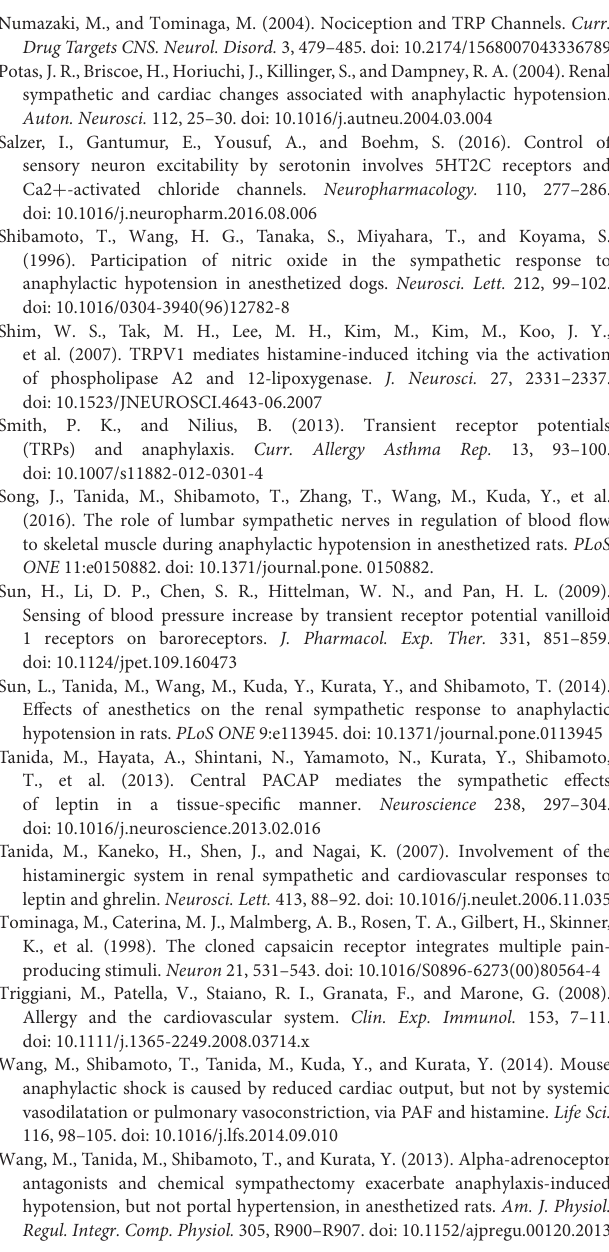
Supplemental Figure 1 | Time-course data of the changes in RSNA (A) , MAP (B,C) and HR (D) after subcutaneous injections of antigen in sensitized mice are shown. • , antigen 0.1 mg; (cid:3) , antigen 1 mg; N , antigen 10 mg. The numbers of mice used are given in parentheses. Values are expressed as means ± SD. # P